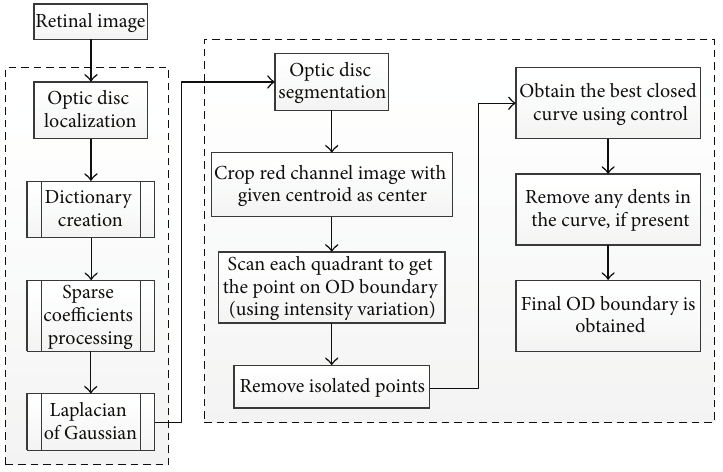
Figure 22: Flowchart for algorithms proposed in [28, 40].